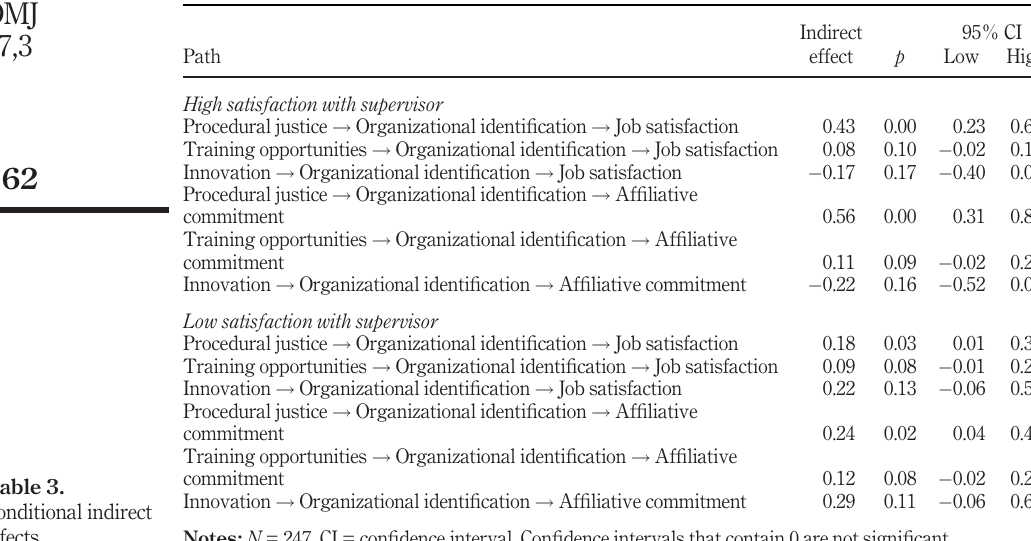
Table 3. Conditional indirect